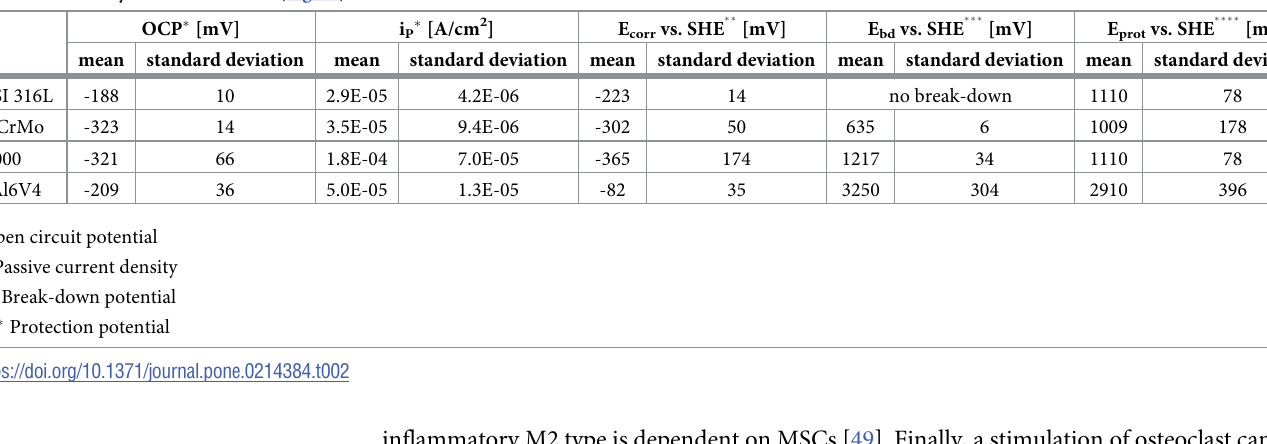
S1 Fig. Indirect XTT proliferation (A) and LDH cytotoxicity (B) assays. Fibroblasts incu- bated with extracts of the material specimens for 24 h were stained. Cells were incubated with extracts of plastic cell culture plates and RM-A sheets as controls. Data are presented as